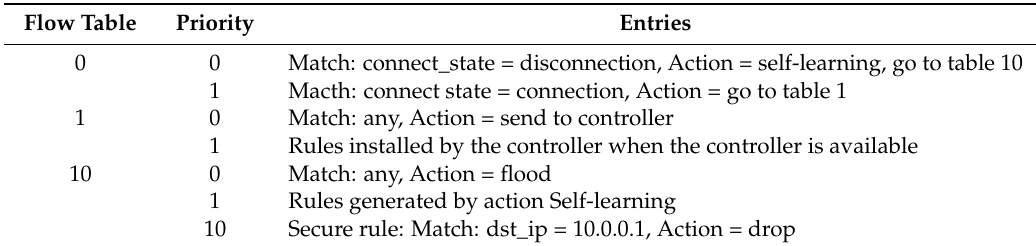
Table 1. Rules in the Proposed Architecture.